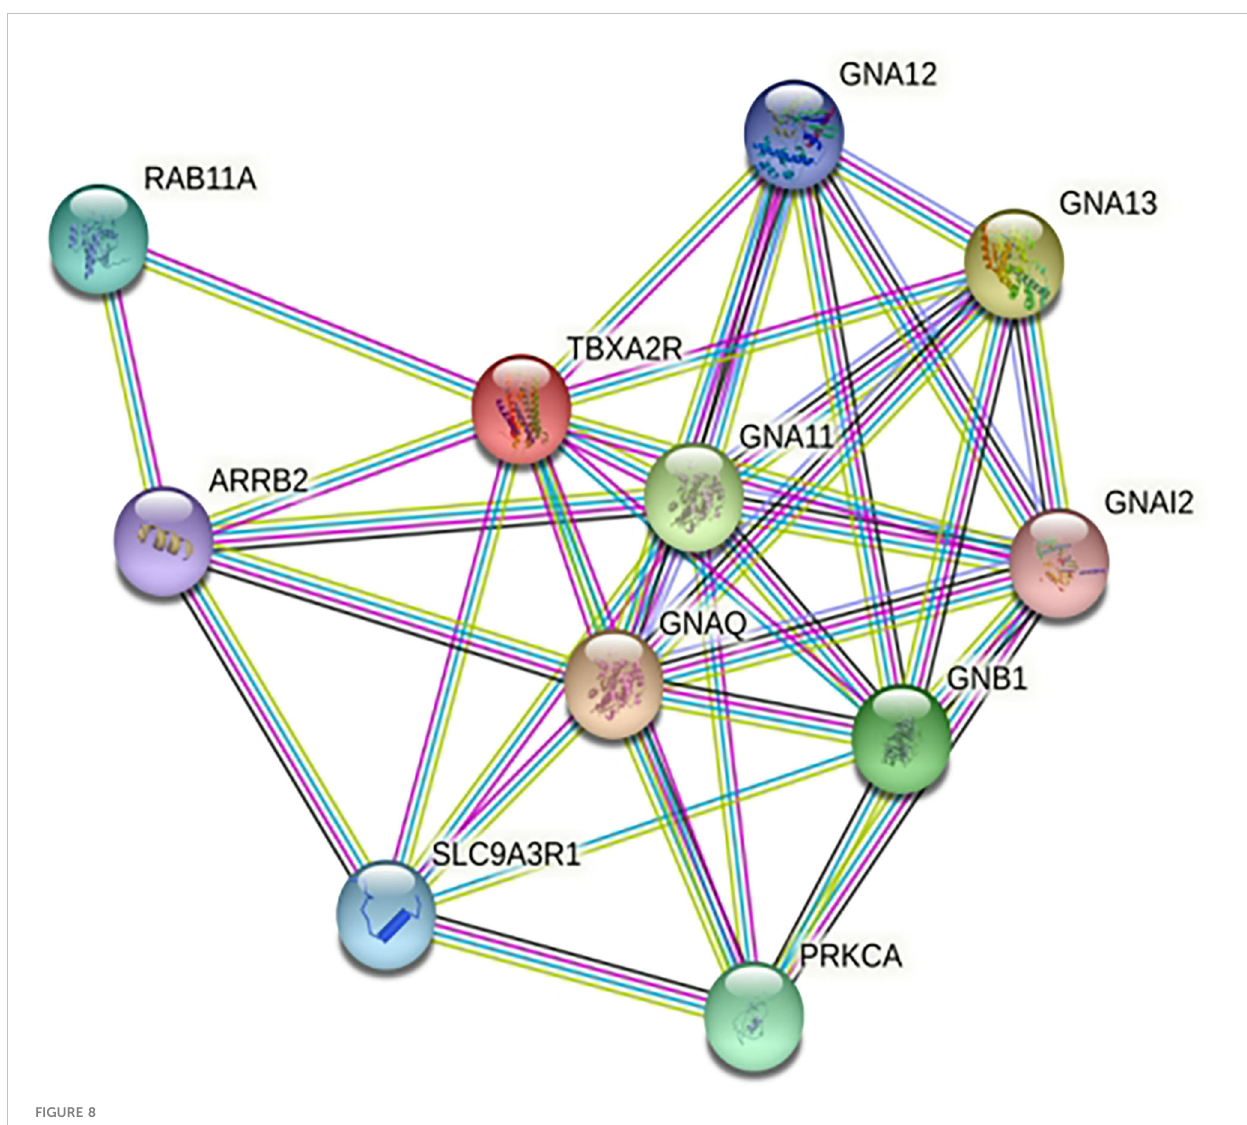
FIGURE 8 Protein- protein interaction network of